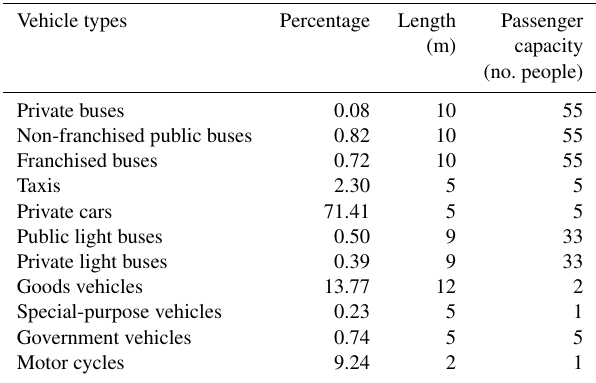
Figure 2. Typical cross section of the slope and the landslide studied in this paper.